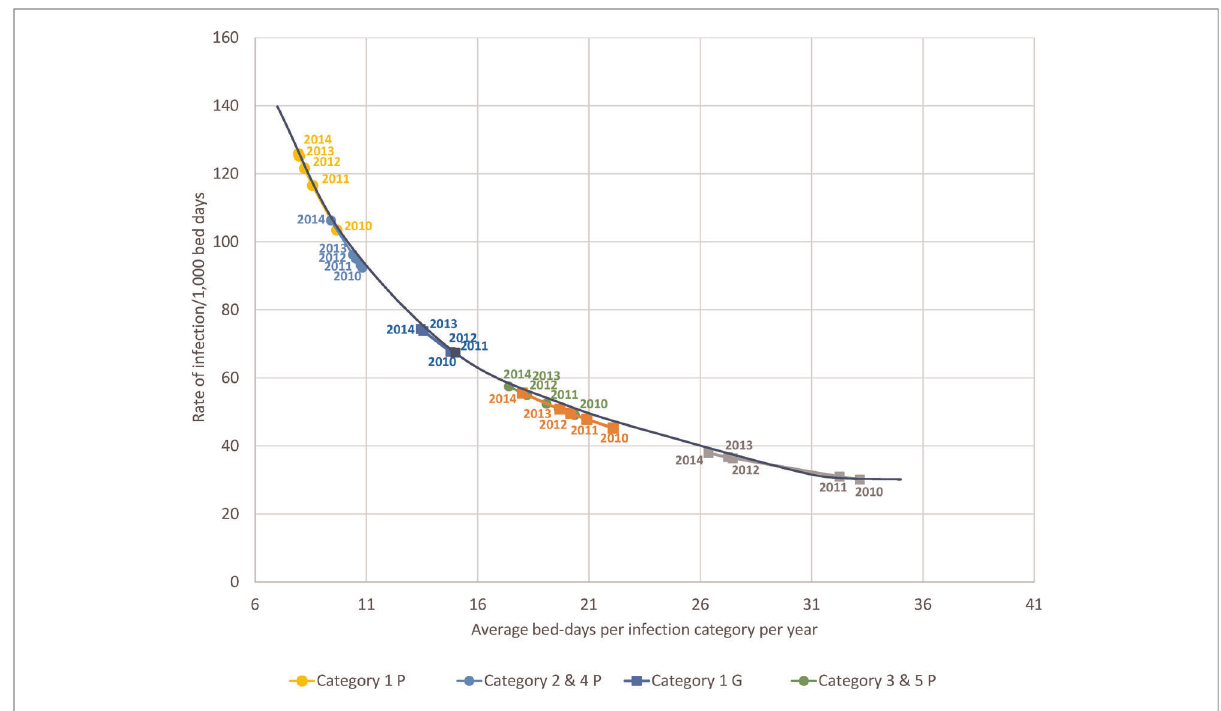
FIGURE 8 The observed relationship between average bed-days per stay by infection category measured per year and the rate of infection for each category in the geriatric (squares) and pulmonology wards (circles). G, Geriatric; P ,